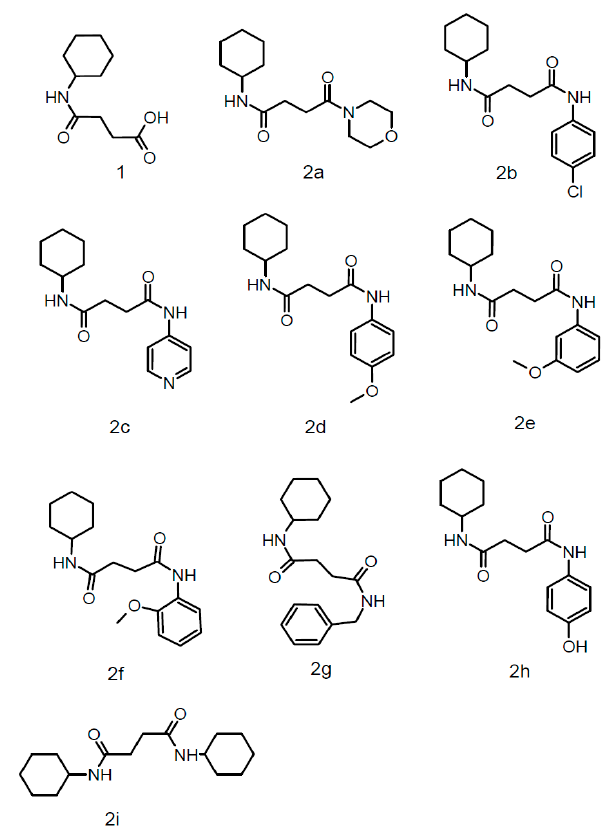
Figure 2. Structures of all newly synthesized succinamide derivatives.